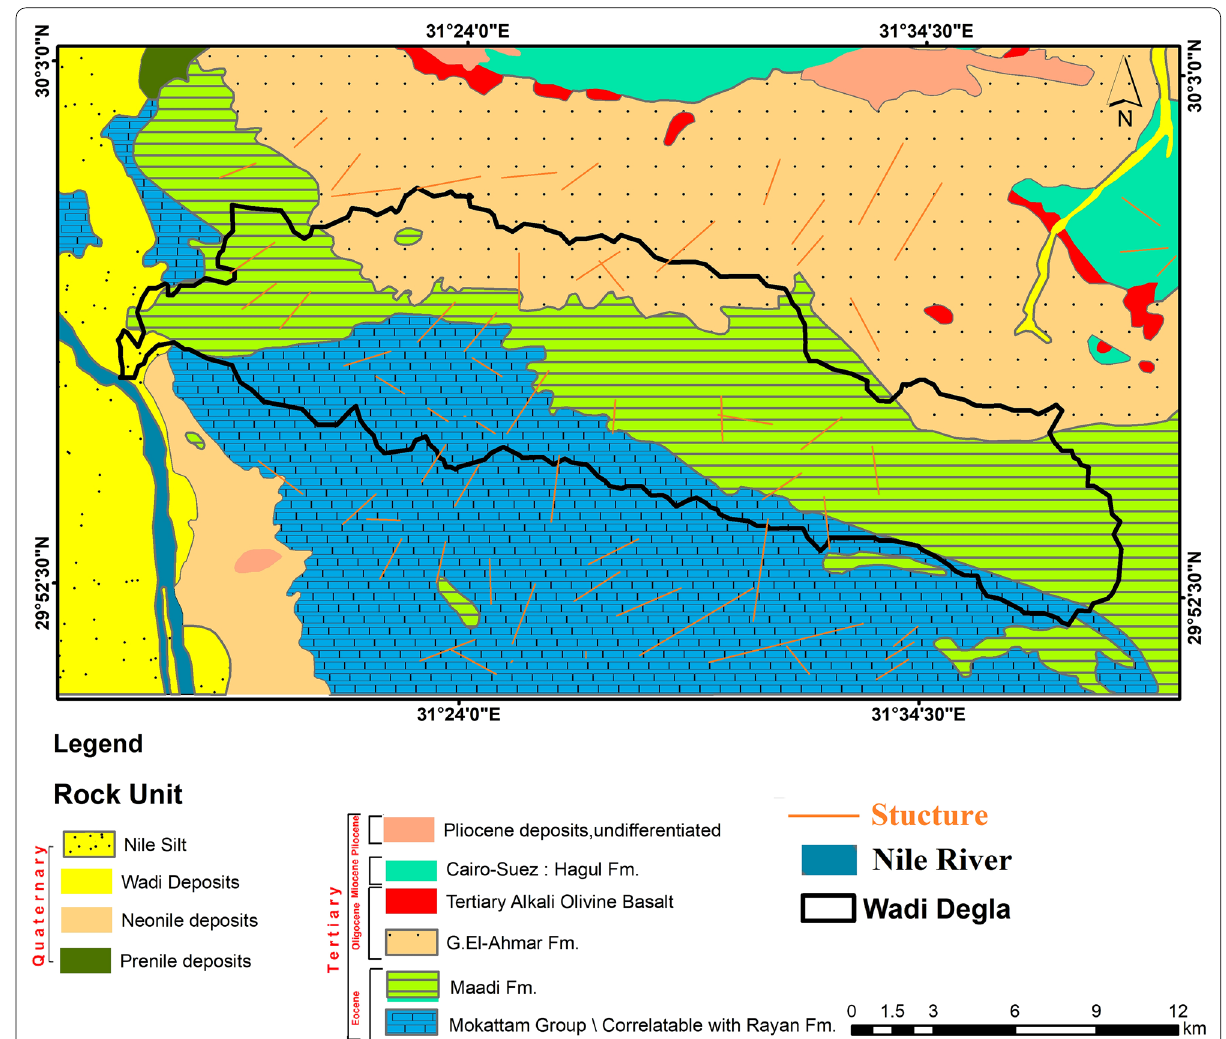
Fig. 3 Geological map of the study area. Modified by CONOCO